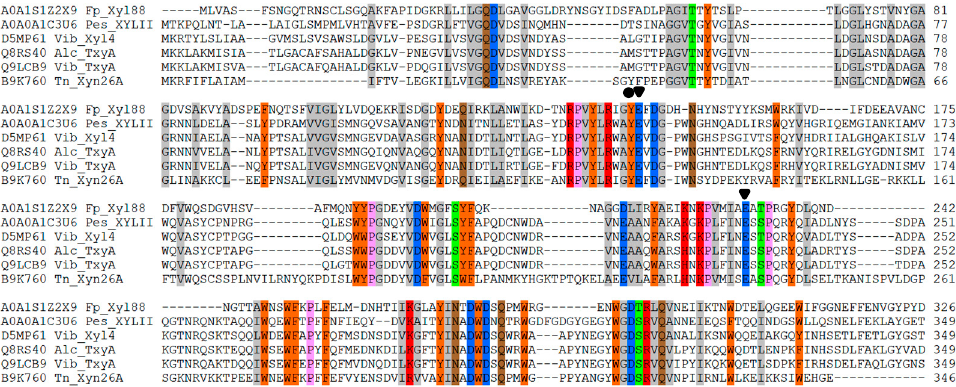
Figure 9. Multiple sequences alignment of biochemically characterized β -1,3-xylanases catalytic domain with Xyl88.